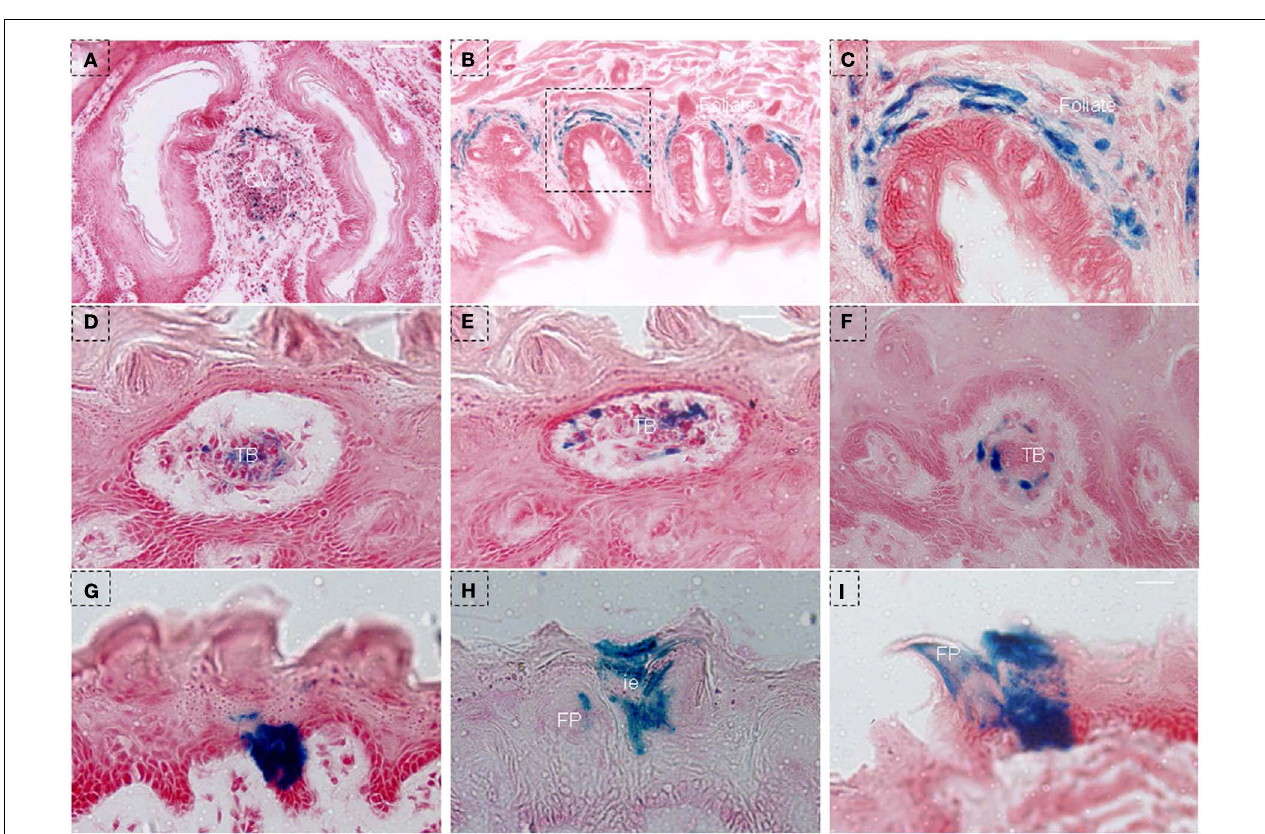
horizontal sections of fungiform papillae. LacZ staining was observed in the developmental papillae (F) , the area between the arm of the U-shaped connective tissue core (G) , interpapillary epithelium (H) filiform papillae and lingual epithelia (I) . CV, circumvallate papillae; FP, filiform papillae; FuP, fungiform papillae; ie, interpapillary epithelia;TB, taste bud. Scale bar: (A,B) , 125 µ m; (C–I) , 12 µ